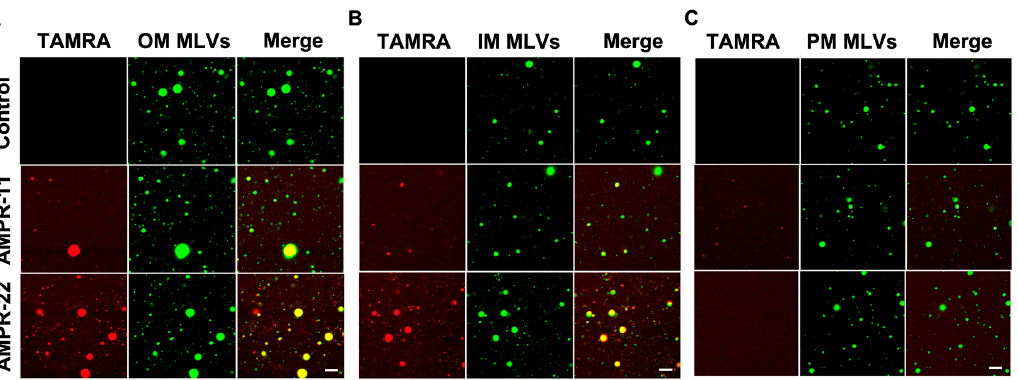
Figure 4. Interaction of AMPR-11/22 with the model membranes. Artificial MLVs containing 0.5% NBD-PE (molar ratio) were incubated with 5 µg/mL TAMRA-labeled AMPR-11/22 for 10 min. AMPR-11/22 interaction with the bacterial OM ( A ), IM ( B ), or PM ( C ) was monitored via confocal microscopy. Scale bar, 20 µm.